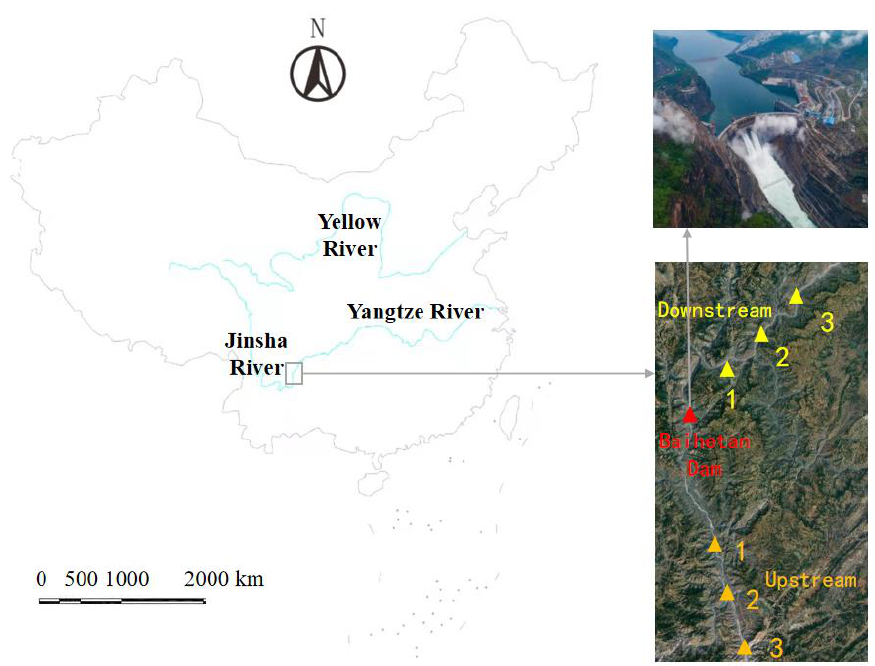
Figure 1. Study area. The photo of Baihetan Dam is from the official website of the China Three Gorges Corporation [10].